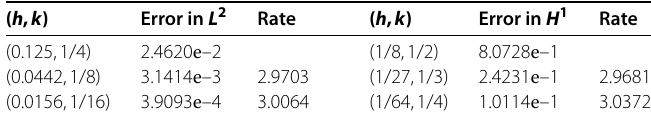
Table 5 The errors and convergence rates of u – u hk in the L 2 and H 1 norms concerning k at